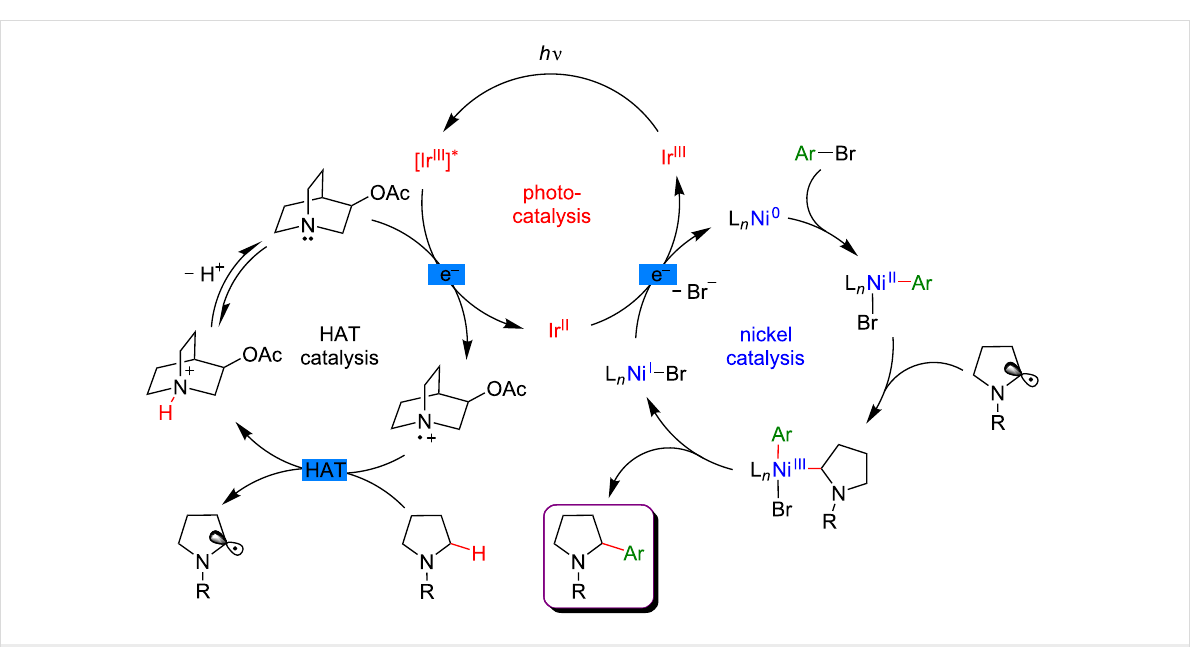
Figure 57: Proposed mechanism for the C(sp 3 )–H arylation of latent nucleophiles promoted by